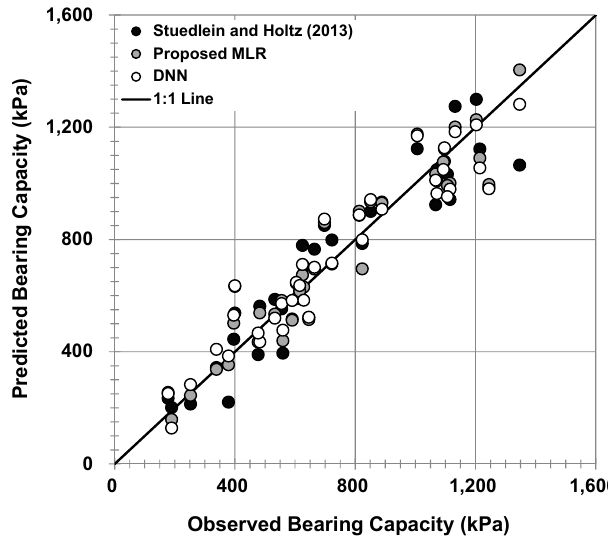
Figure 12. Comparison of the predicted and the observed ultimate bearing capacity by leave-one-out cross-validation.